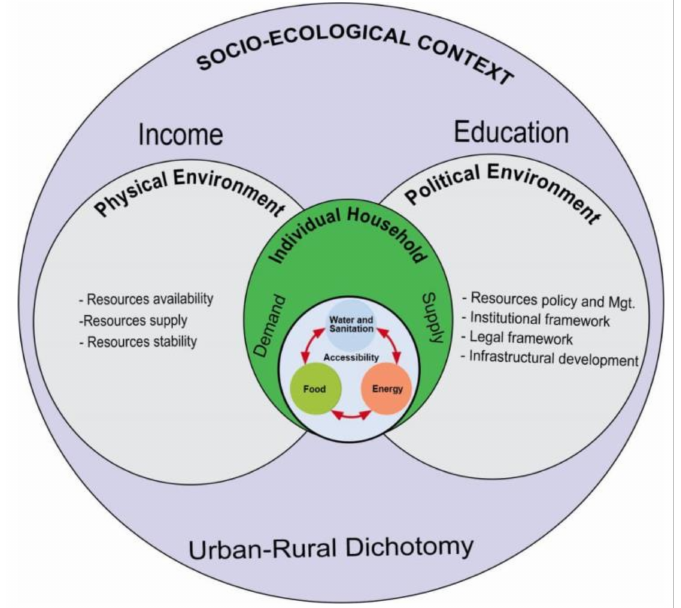
Figure 2. Socio-ecological model of water, energy and food